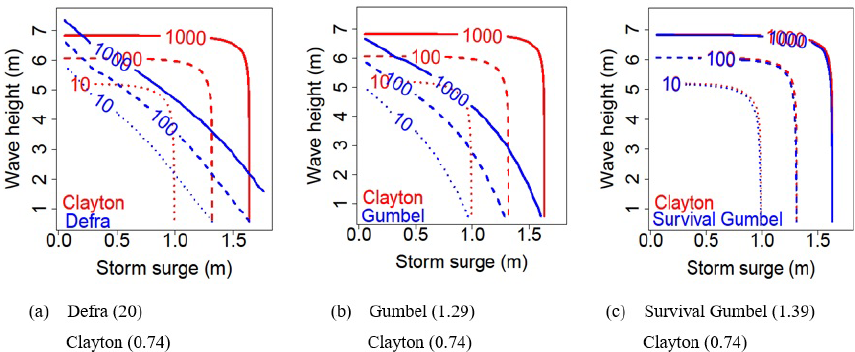
Figure 7. Contours of equal joint exceedance probability with Clayton (0.74), Defra (20), Gumbel (1.29) and survival Gumbel (1.39) for return periods of 10, 100 and 1000 years for Le Havre.